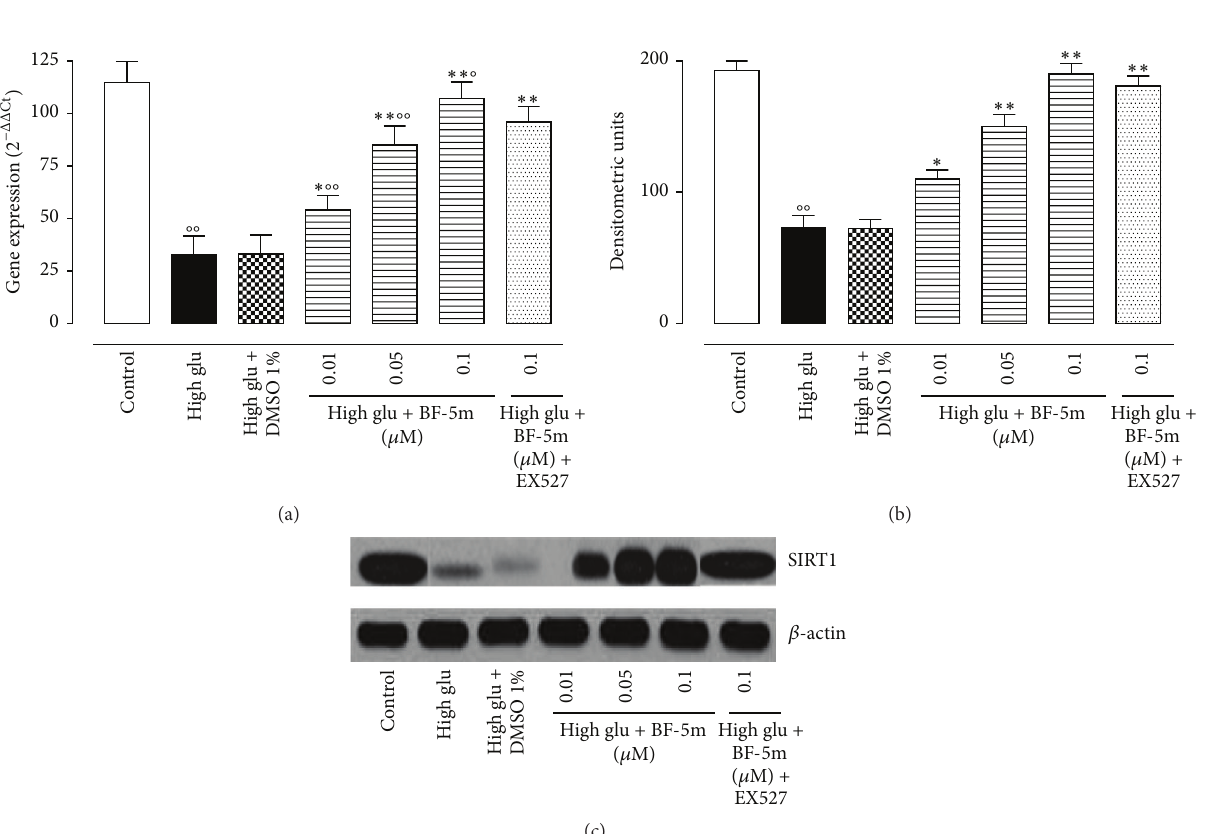
Figure 3: (a) SIRT1 in perfused hearts following treatment with D-glucose 11.1mM (control); glucose 11.1mM + DMSO 1% (vehicle); glucose 33.3 mM (high glu); high glu + BF-5m (0.01, 0.05, and 0.1 𝜇 M); high glu + BF-5m (0.1 𝜇 M) + EX527 (10mg/kg/day i.p.). Total RNA was extracted from the hearts and reverse transcribed into cDNA using superscript reverse transcriptase system. The expression of SIRT1 was quantified by qPCR using commercially available rat primers. Results are expressed as arbitrary units based on calculation of 2 −ΔΔ Ct method. ∘ 𝑃 < 0.01 versus control; ∗ 𝑃 < 0.05 and ∗∗ 𝑃 < 0.01 versus high glu. (b) Addition of BF-5m (0.01, 0.05, and 0.1 𝜇 M) to the high glucose Krebs solution dose-dependently increased the expression of SIRT1. Results are derived from western blotting (panel (c) representative) and expressed as densitometric units (mean ± s.e.m. of 𝑛 = 10 observations for each group). Significant differences versus control are reported as ∘ 𝑃 < 0.05 and ∘∘ 𝑃 < 0.01 ; significant differences versus high glu are reported as ∗ 𝑃 < 0.05 and ∗∗ 𝑃 < 0.01 ; significant differences versus high glu + BF-5m 0.1 𝜇 M are reported as ∘ 𝑃 < 0.01